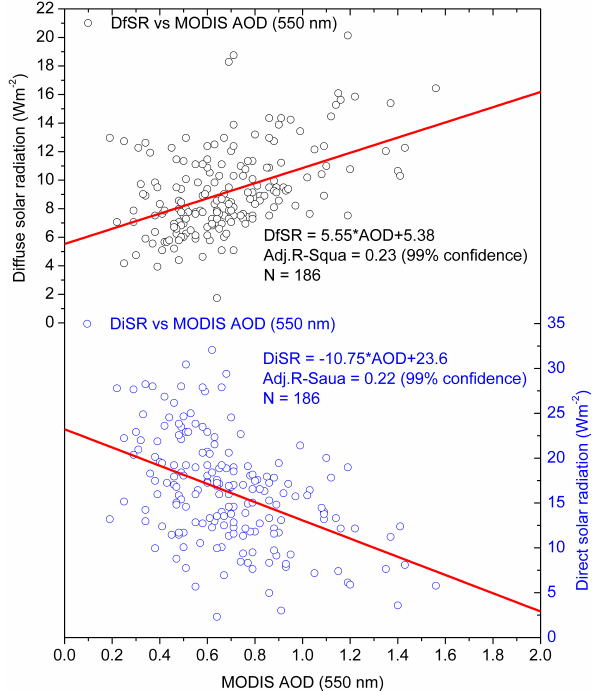
Fig. 5. Same as Fig. 3, but in